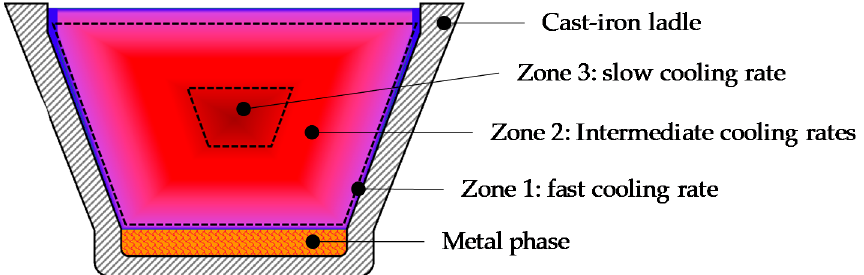
Figure 4. Schematic illustration of the slag ladle with expected cooling zones and cooling rates.